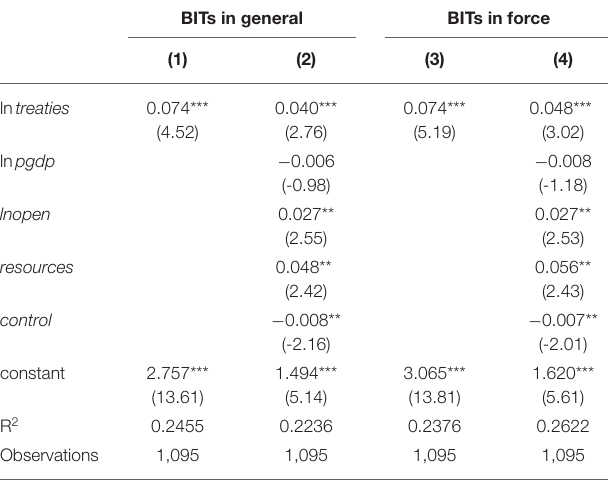
TABLE 2 | Estimation results (entire sample, 2005–2016). TABLE 3 | Results of civil law system and common law